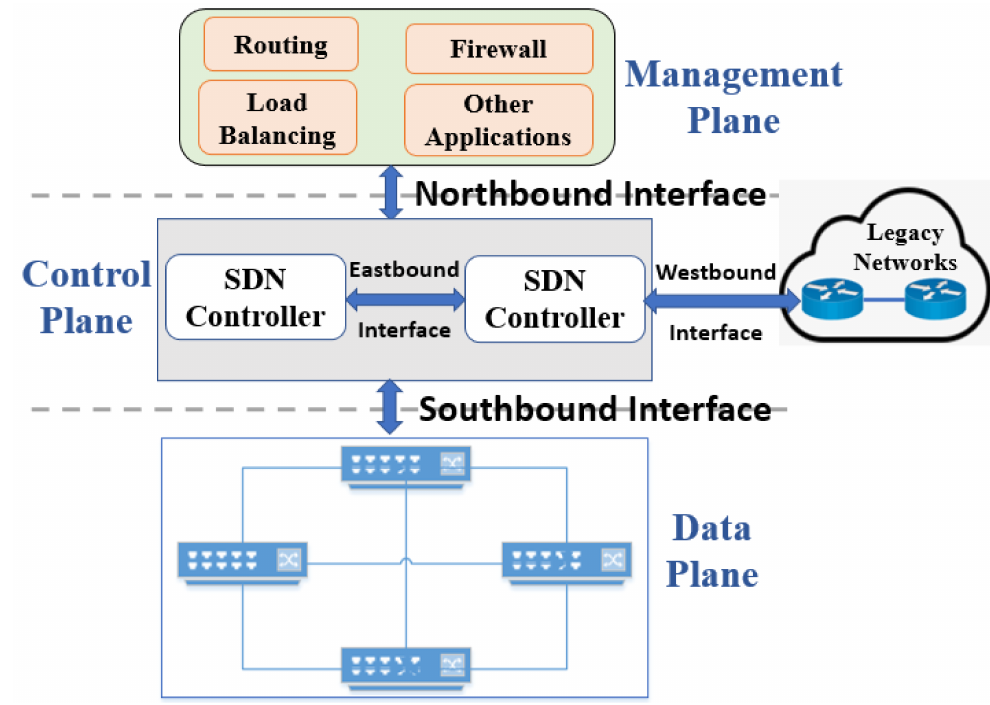
Figure 1. Architecture of an SDN system